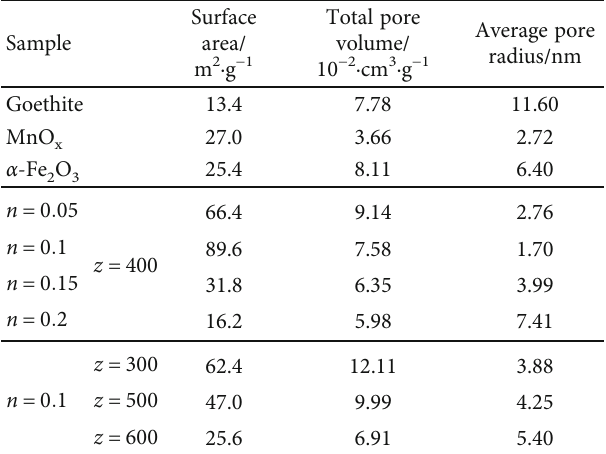
Table 2: BET surface area, total pore volume, and average pore radius of goethite, MnO molar ratios and calcination